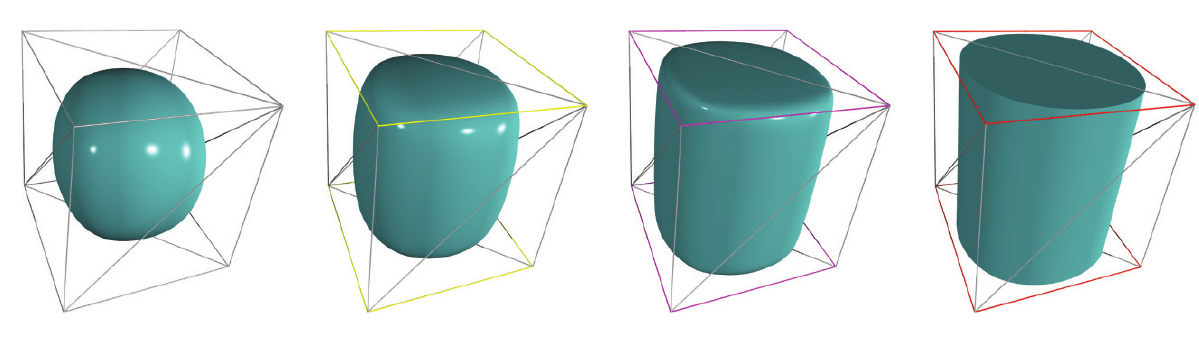
Fig. 3 Examples of different values of edge sharpness. The control mesh is drawn as a wireframe. Edges with different sharpness are drawn in different colors: gray, yellow, magenta, and red correspond to h e = 0 , 0 . 6 , 0 . 9 , 1,